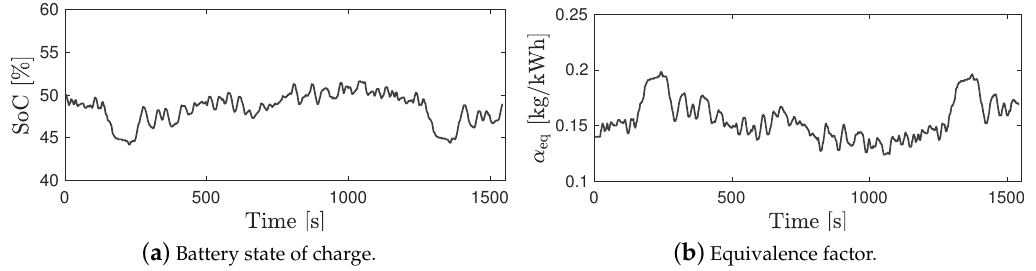
Figure 12. The battery state of charge and A-ECMS equivalence factor variation during experiments, ( a ) state of charge, ( b ) equivalence